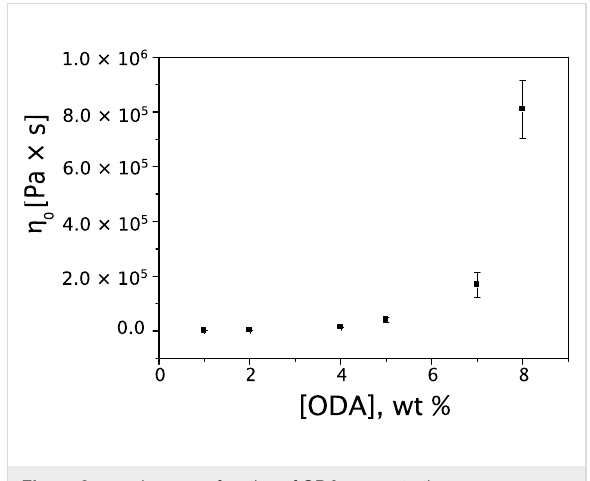
Figure 2: η 0 values as a function of ODA concentration.